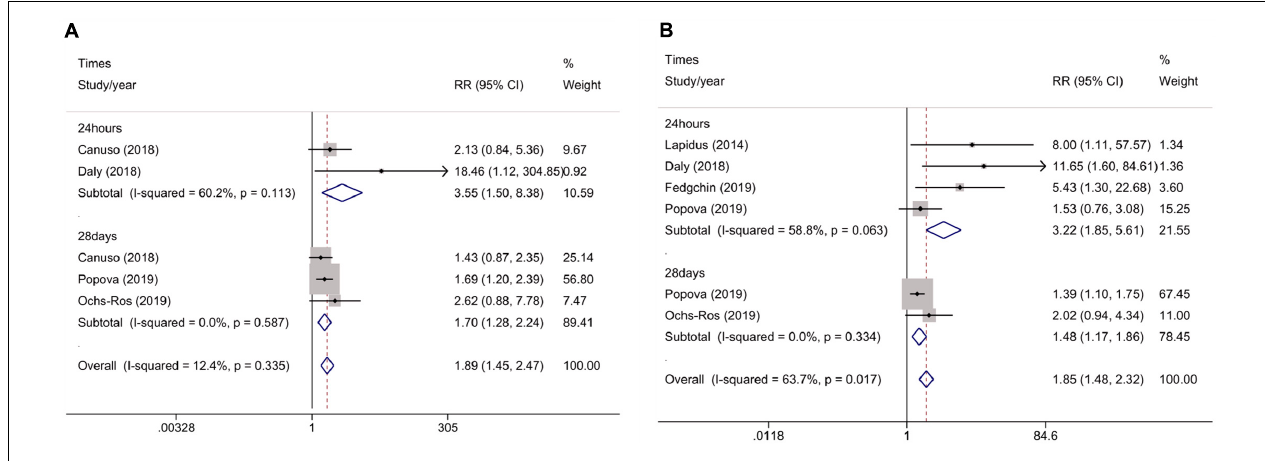
FIGURE 4 | Meta-analysis of rates of clinical remission (A) and rates of clinical response (B) for ketamine v. placebo in major depression.